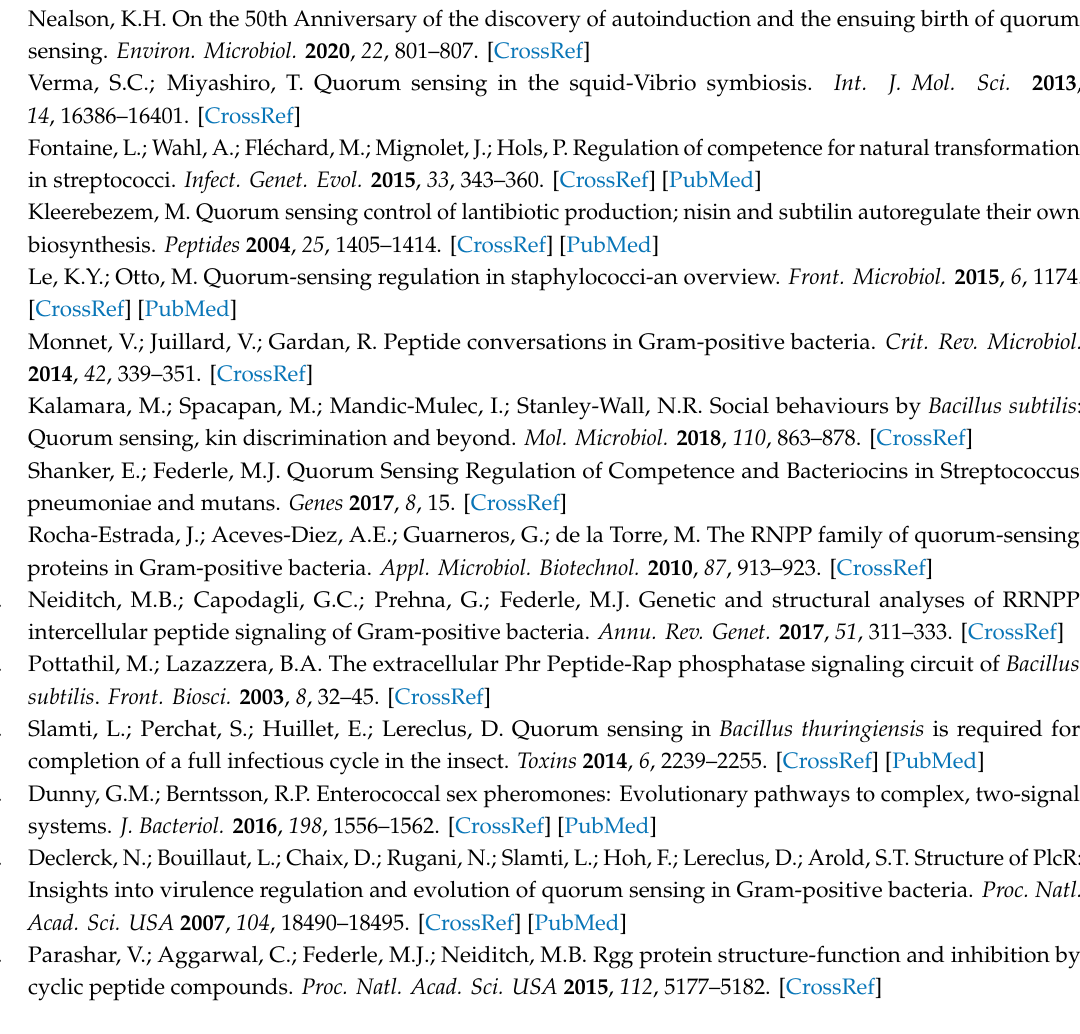
Figure S3: Detection of the mature form of SHP 279 in cultures of the S. thermophilus wild-type strain (LMD-9) via LC-MS / MS. Fragmentation spectra for SHP 279 (A); mass, retention time, and the integrated area under the curve obtained from the extracted-ion chromatograms for the peptide (B). The data shown are representative of three independent